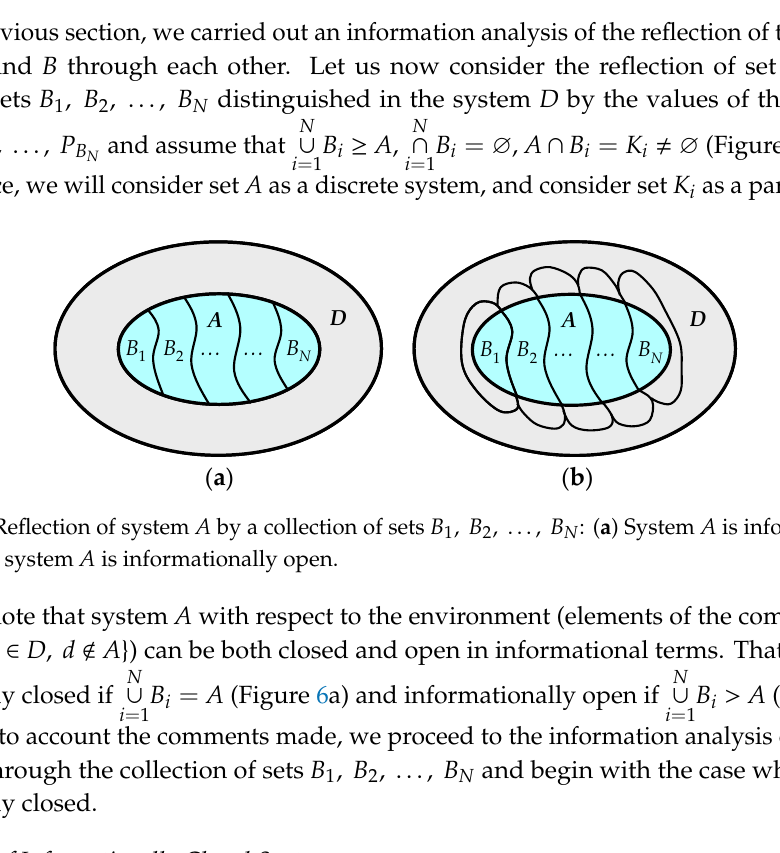
: ( a ) System A is informationally N BBB ...,,, 21